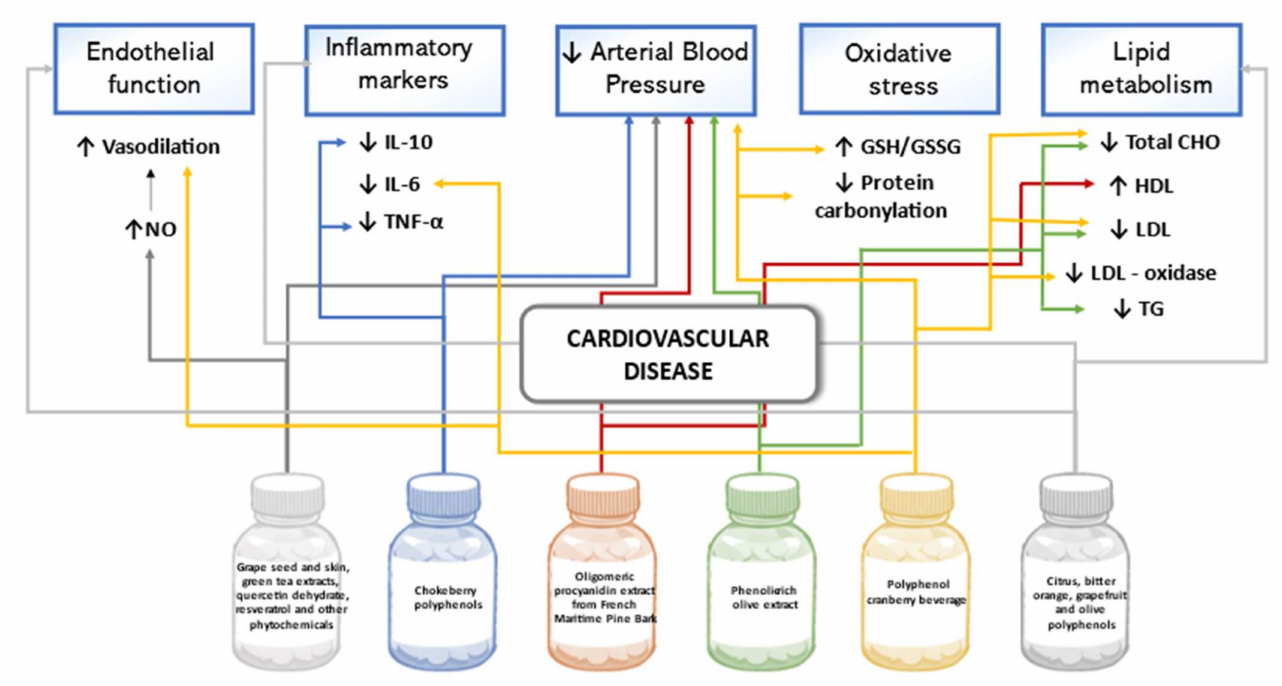
Figure 4. Effects of polyphenols on cardiovascular disease in human